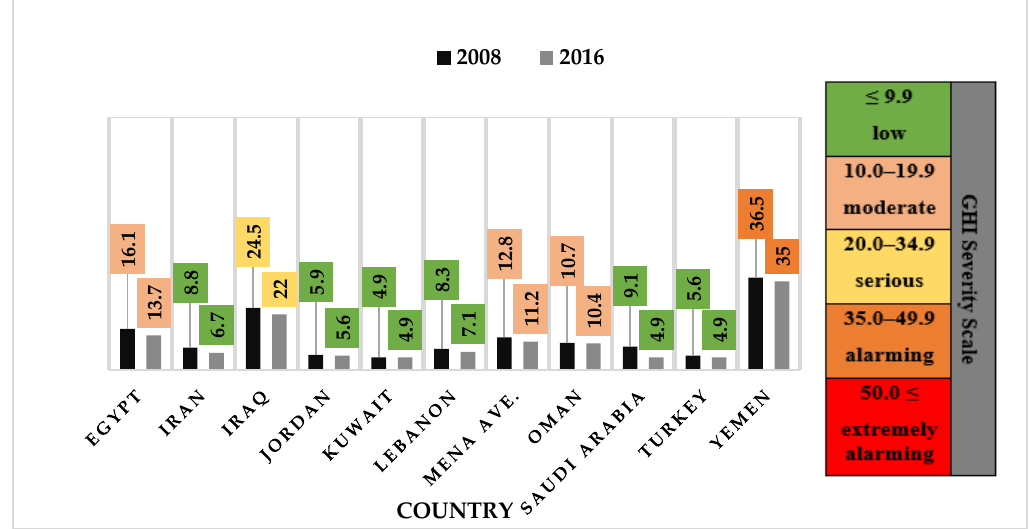
Figure 12. Global Hunger Index (GHI) for the Middle Eastern countries with a range of 0 − 100, where lower score indicates less hunger. Note: data for Syria was not available. The data is acquired from: https://idea.usaid.gov.